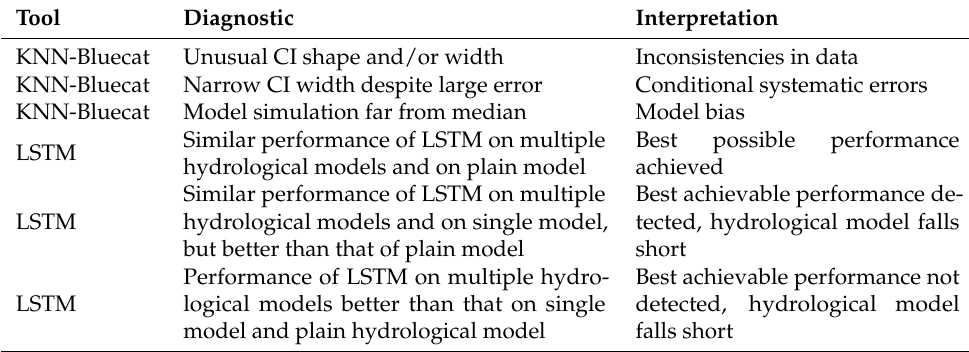
Best possible performance achieved Best achievable performance de- tected, hydrological model falls short Best achievable performance not detected, hydrological model falls